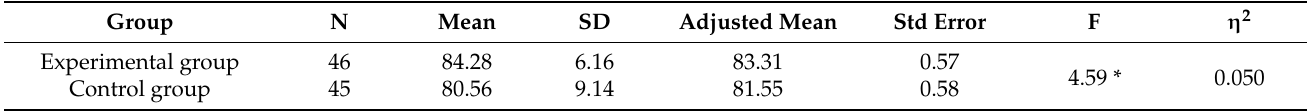
Table 4. The ANCOVA results for learning achievement.